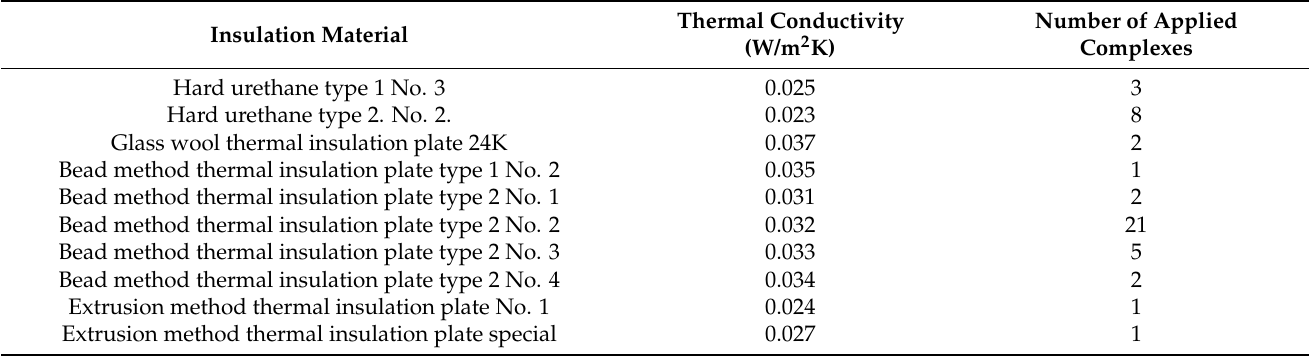
Table 2. Results of investigation on external wall insulation in 46 MDU